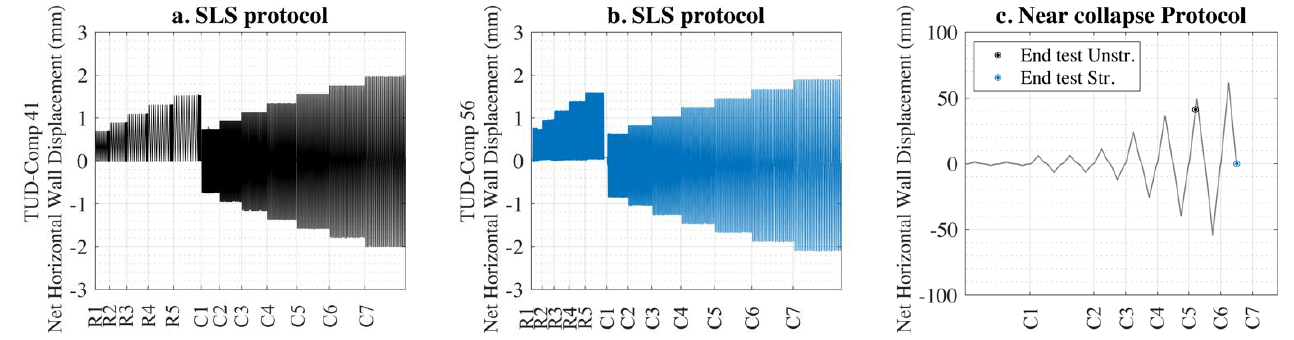
Figure 7. Loading protocol: ( a ) SLS part unstrengthened wall; ( b ) SLS part strengthened wall; ( c ) ULS part for both walls.